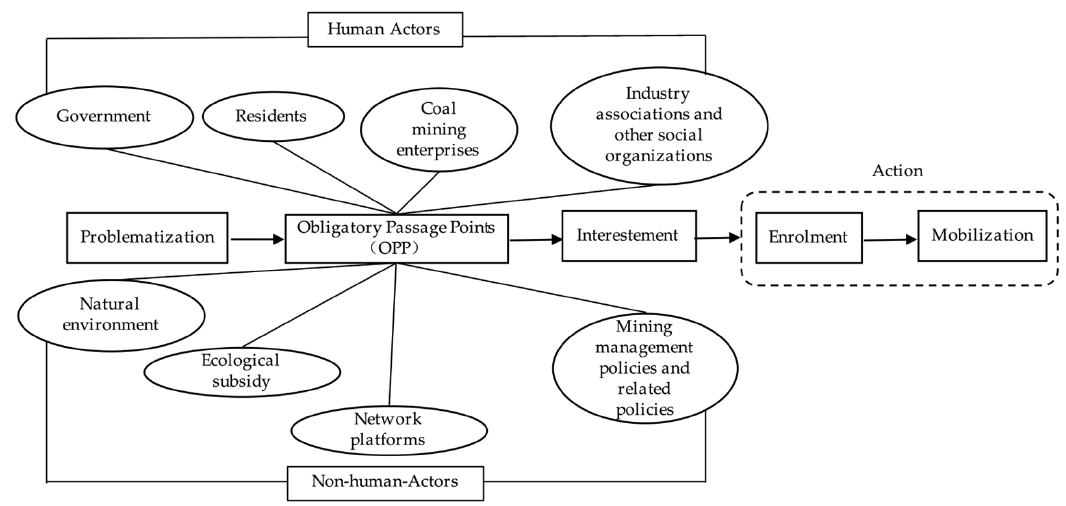
Figure 2. Actor-network analysis framework. Source: organized by the authors.